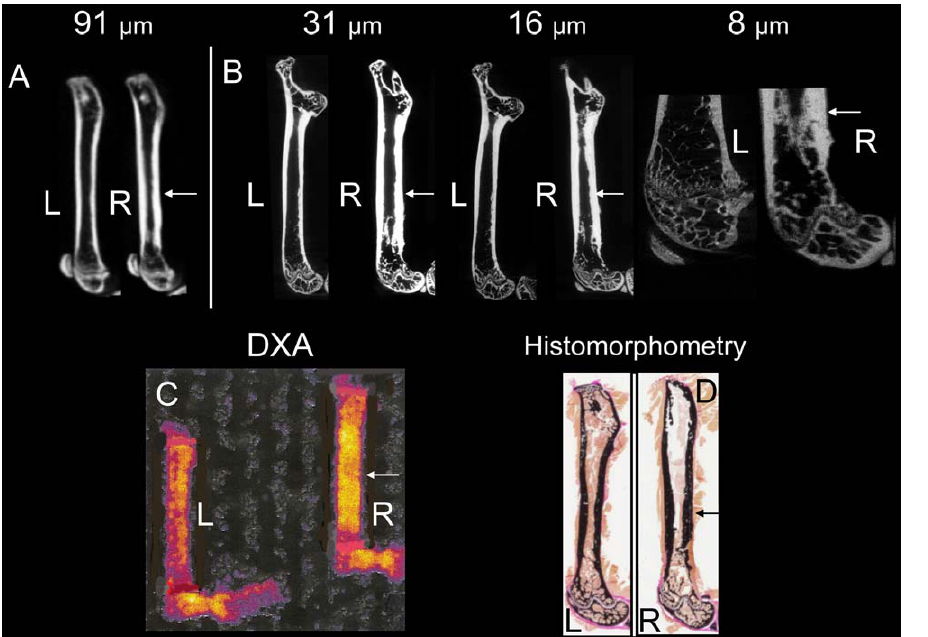
Figure 3. Representative in vivo and ex vivo images demonstrate morphologic changes of mineralized cortical and trabecular bone induced by prostate cancer involving the skeleton. Sagittal in vivo m CT and ex vivo specimen m CT images of femora 10 weeks after injection of vehicle (left) or prostate cancer cells (right). (A) In vivo m CT (91- m m voxel size); (B) ex vivo specimen m CT at 31- m m, 16- m m, and 8- m m voxel sizes; (C) ex vivo dual-energy X-ray absorptiometry (DXA); and (D) bone histomorphometry images are presented. L, left femur; R, right femur with tumor; arrow, cortical thickening.